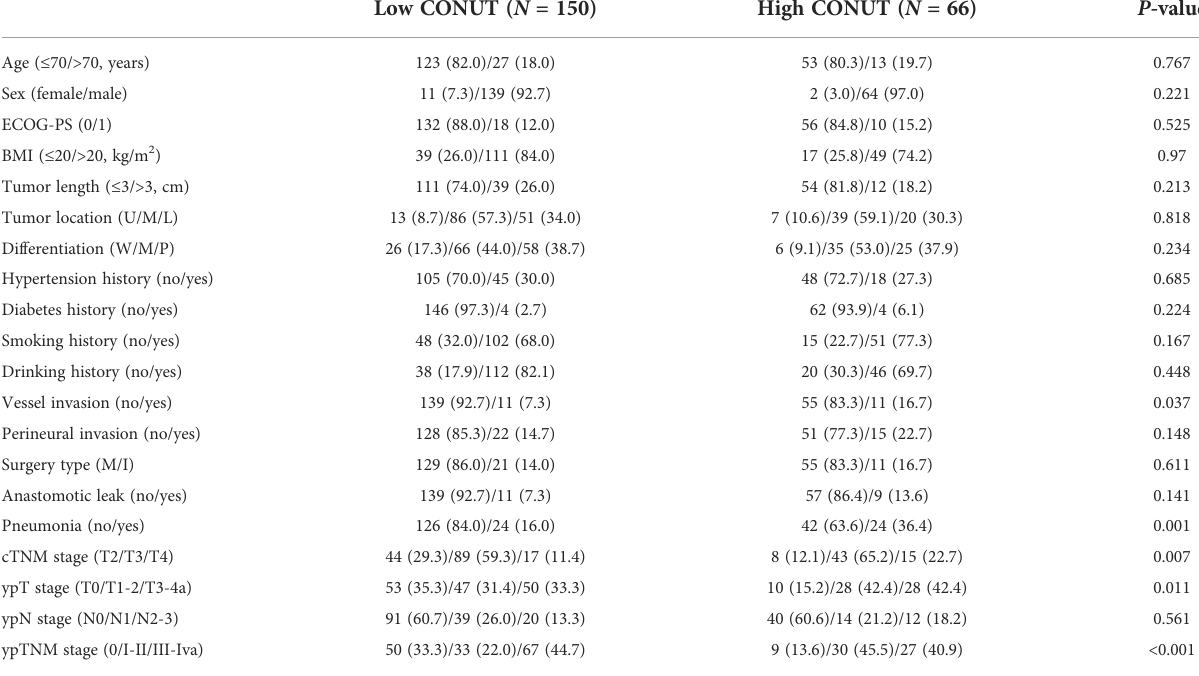
TABLE 2 Comparison of the clinical variables in esophageal squamous cell carcinoma grouped by CONUT. Low CONUT ( N = 150) High CONUT ( N =